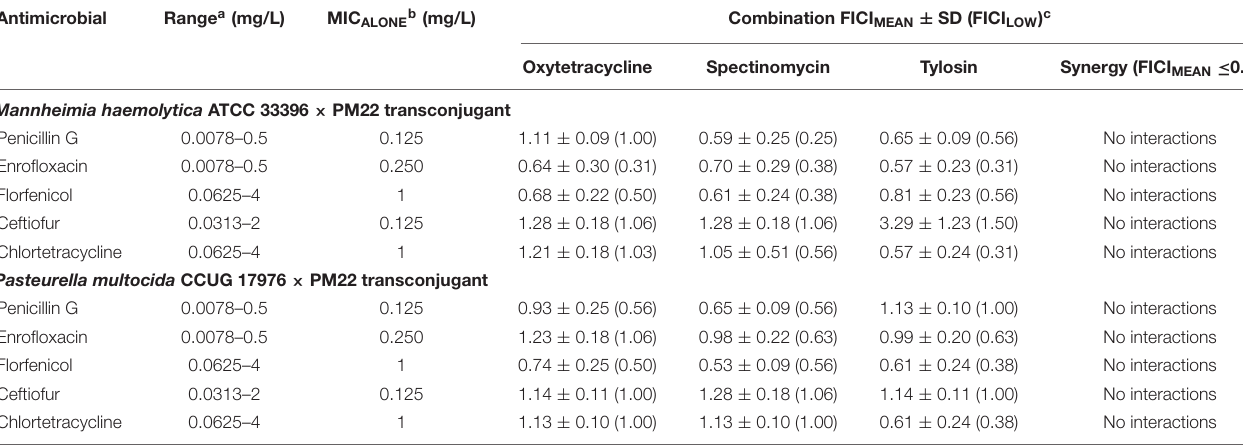
TABLE 3 | Results of checkerboard synergy testing (FICIs) with non-susceptible and susceptible antimicrobial combinations.